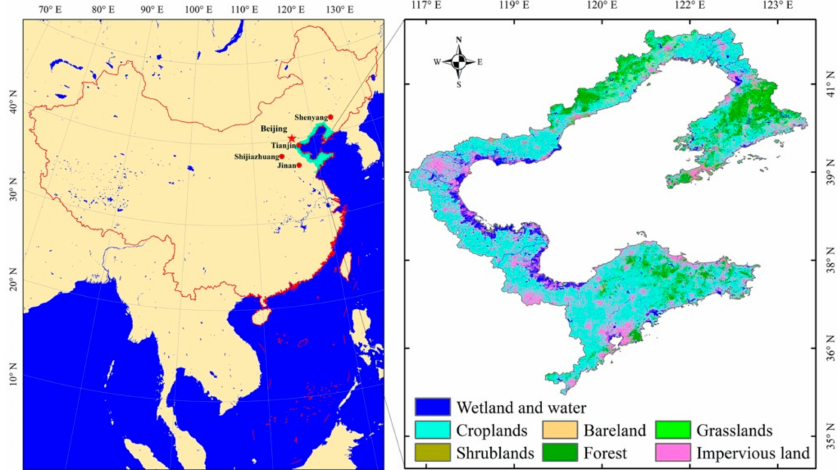
Figure 1. Location and land cover types of the study area. The land cover data is from the FROM-GLC10 data